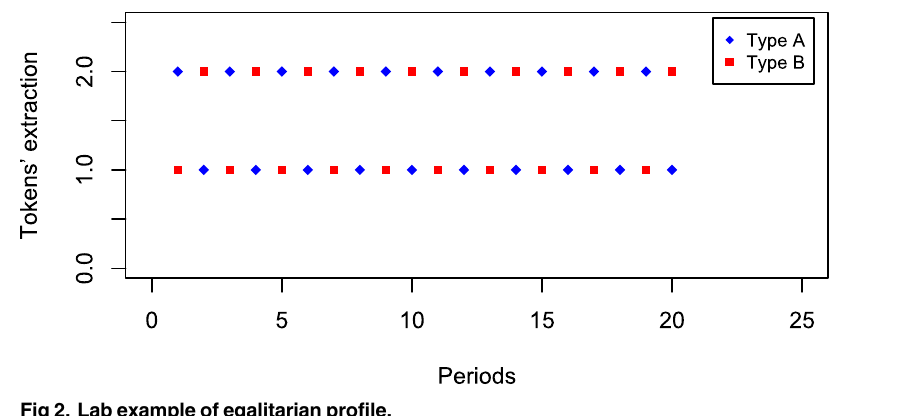
Fig 2. Lab example of egalitarian